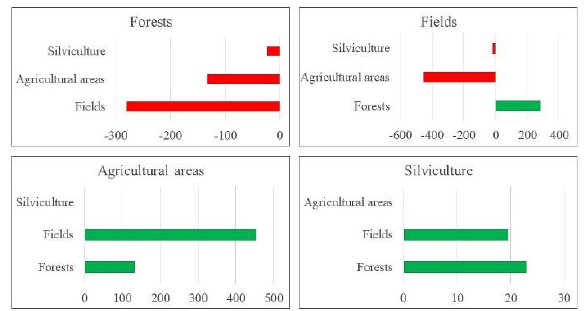
Figure 6. Transition of land use and land cover classes in the Chapadinha microregion (2000-2009 period).